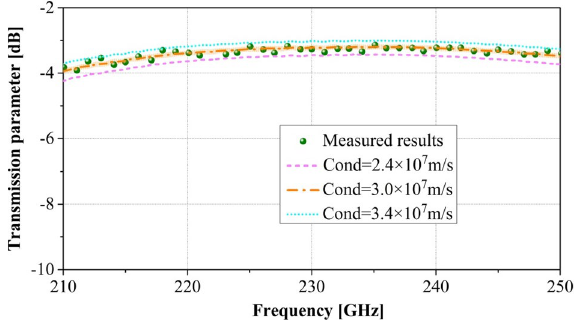
Figure 11. Comparison between measured results and simulated results of transmission parameters.